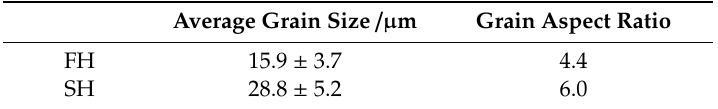
Table 3. The average grain size and grain aspect ratio of the FH sample and SH sample after solution treatment.